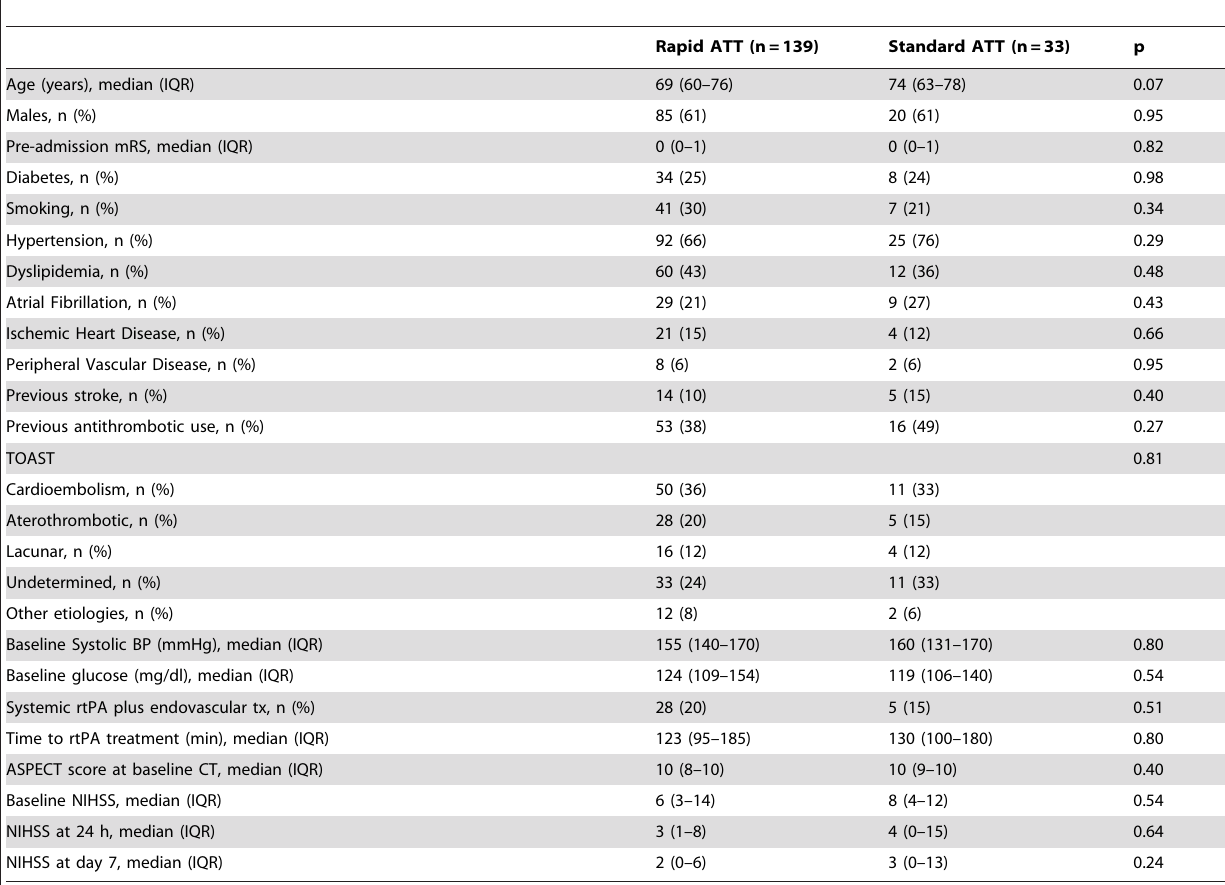
Table 1. General characteristics of study population according to ATT onset group.